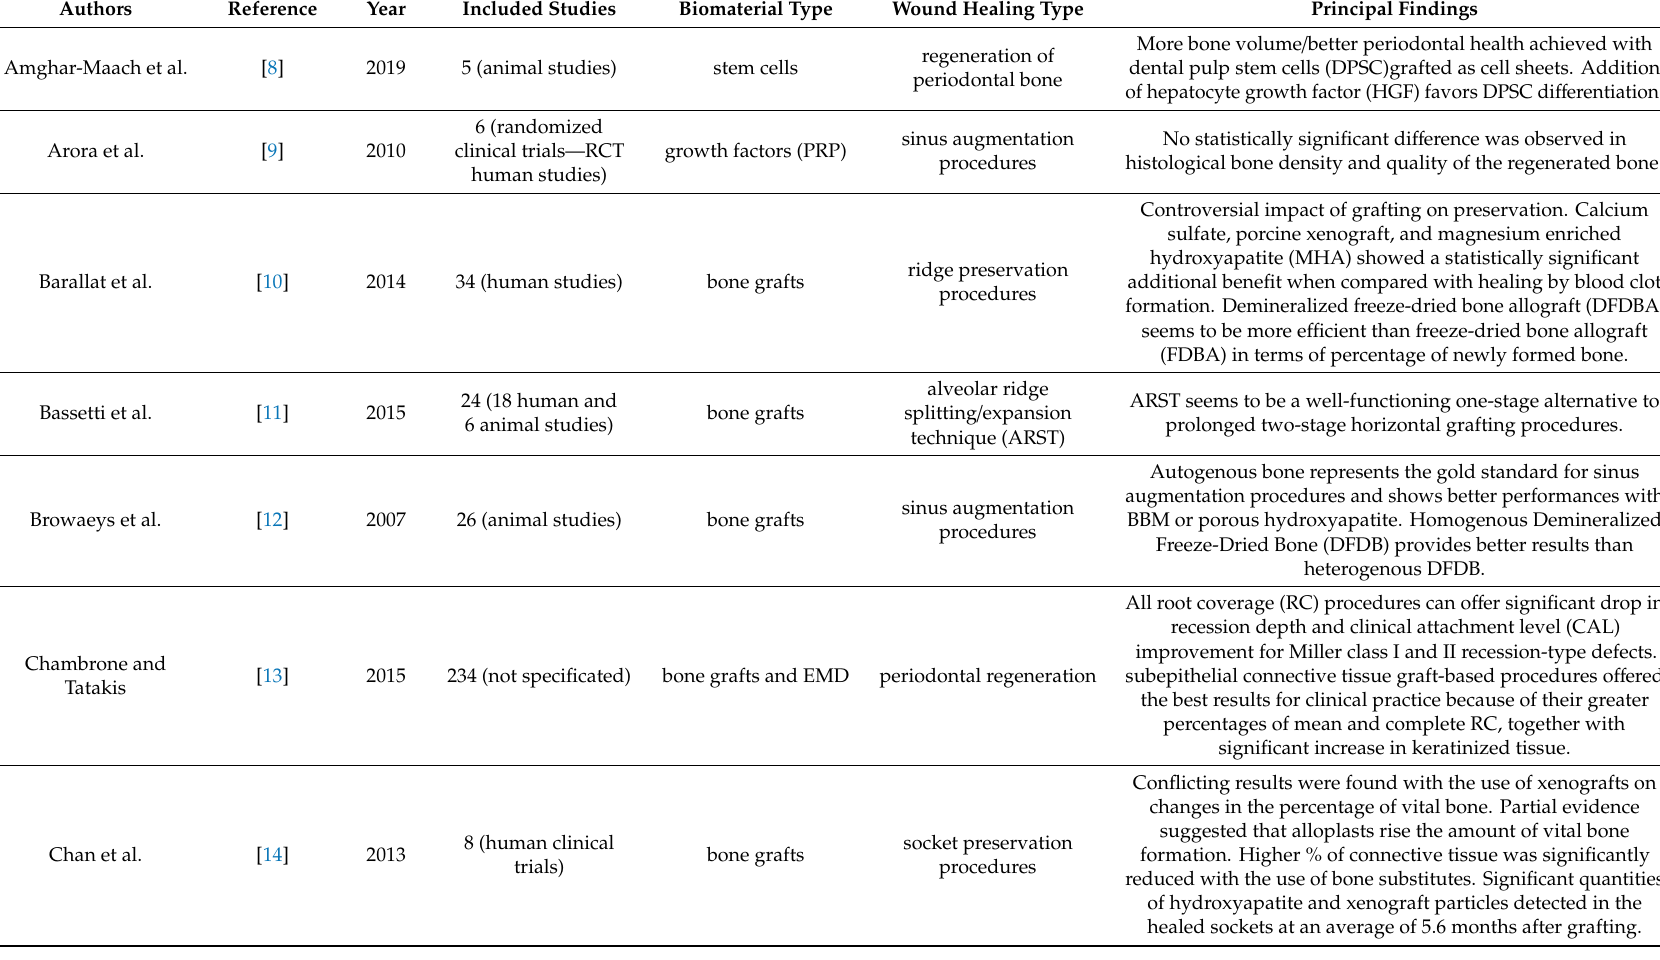
Table 1. Included